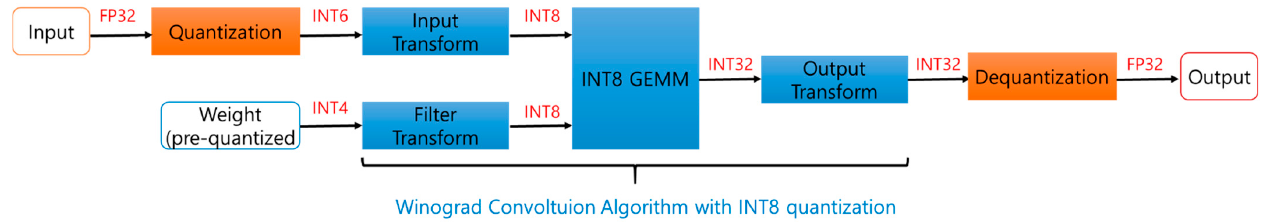
Figure 7. Schematic diagram of Winograd convolution algorithm applying INT8 quantization.